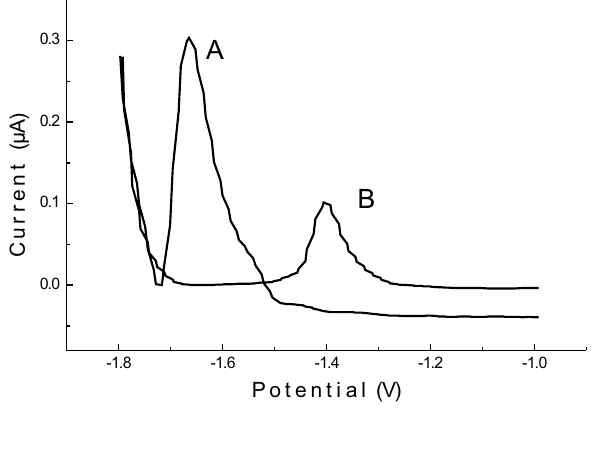
Fig. 1 – Differential pulse polarograms obtained for 5 . 0 × 10 − 4 mol L –1 of miconazole in pH 8.0 (Curve A) in pH 12.0 (Curve